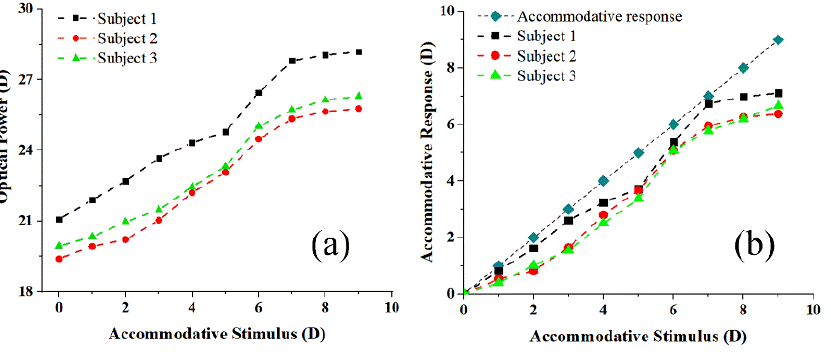
Figure 9. Variations of refractive power ( a ) and accommodative response ( b ) with accommodation stimulus in 3 subjects.